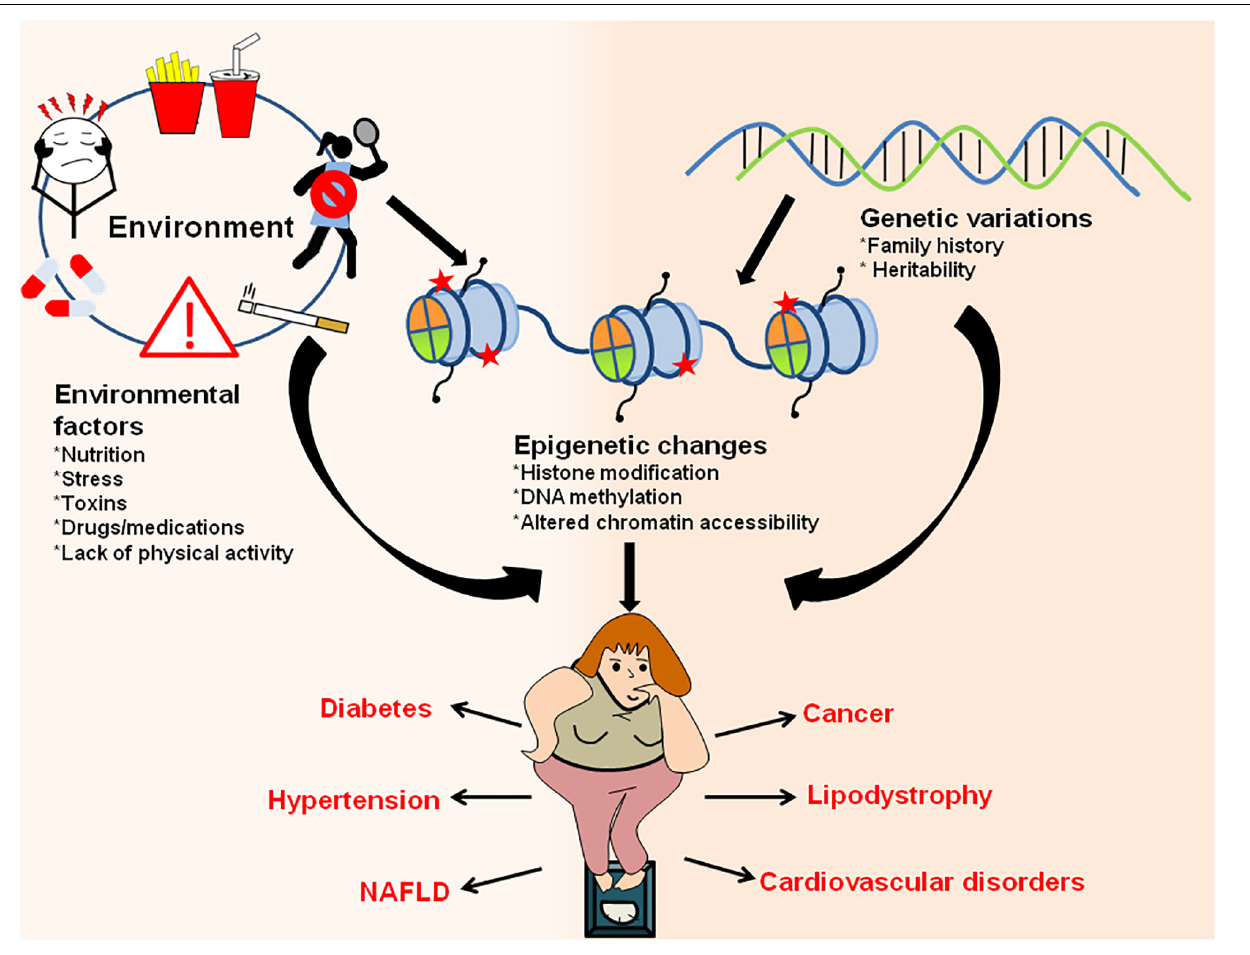
FIGURE 6 | Interaction between environment/genetic factors and epigenetic changes in establishment of obesity and obesity-associated metabolic disorders. Environmental factors like exposure to drugs/toxic chemicals, lack of physical activity, sedentary lifestyle, poor and unhealthy diet, stress/anxiety, smoking/alcohol abuse along with genetic makeup of an organism can have direct influence on epigenetic marks and result in increased adiposity. The changes in epigenetic landscape through various histone modifications, changes in chromatin accessibility and DNA methylation results in obesity and other metabolic disorders like diabetes, hypertension, lipodystrophy, cardiovascular diseases, NAFLD, cancer,